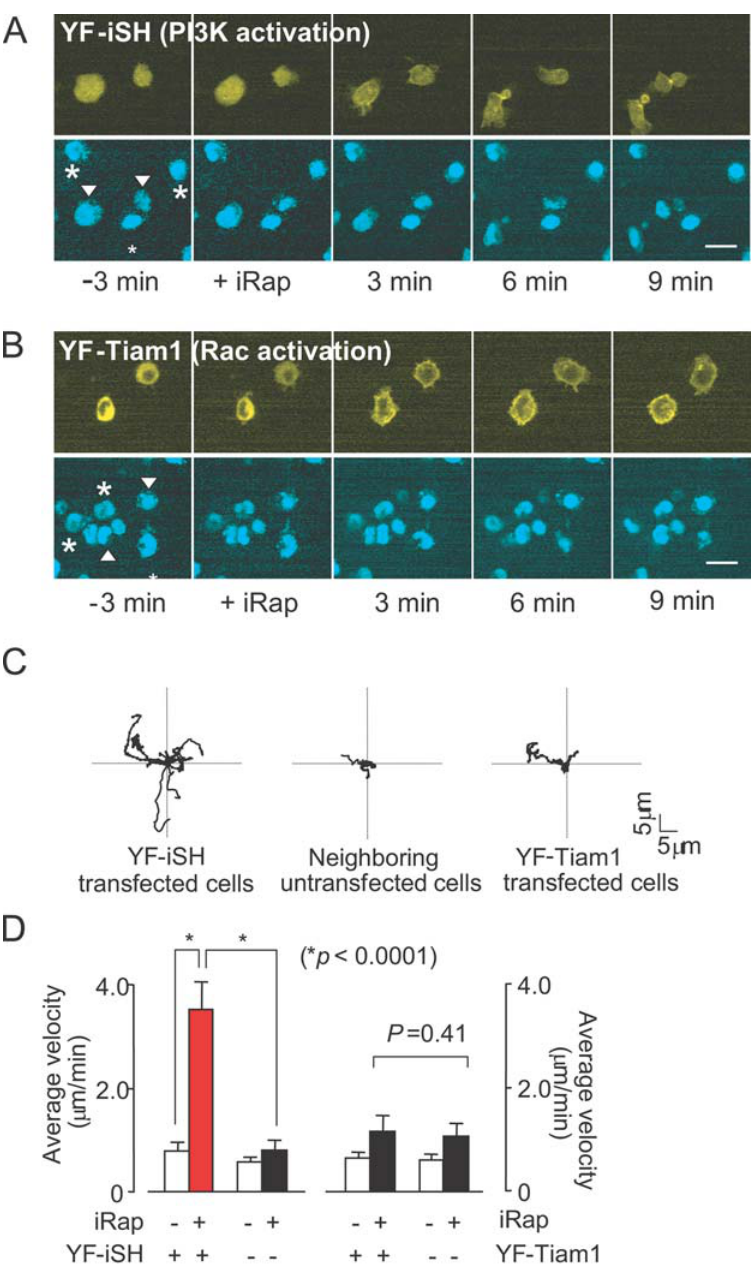
Figure 2. Synthetic activation of endogenous PI3K, but not of endogenous Rac, induces neutrophil polarization and migration. Dual color fluorescent images of differentiated HL-60 cells are shown every 3min before and after iRap addition. (A) Neutrophils polarize and begin to migrate in response to synthetic activation of PI3K. (B) Neutrophils induce non-polar pseudopods in response to synthetic activation of endogenous Rac and do not migrate. Synthetic activation of Rac was based on the forced translocation of catalytic Rac GEF activity (from the exchange factor TIAM). FKBP-YFP-TIAM construct (YF-Tiam1) was expressed instead of the YF-iSH construct. In both image series, the top rows shows the YFP-tagged activation peptides (YF-iSH for PI3K or YF-Tiam1 for Rac), and the bottom images show DyeCycle-labeled nuclei. Arrowheads in images of the nuclei point to the transfected cells, whereas asterisks mark untransfected cells. (C) Migration paths of 10 representative cells for each condition. The initial location was normalized to the origin. Cells after synthetic activation PI3K (left), untransfected control cells in the same field of view (middle), and cells after synthetic activation of Rac (right). (D) Average velocity of cells before and after PI3K activation or Rac activation. Graph shows the velocity at 1.5 min before and 6 min after iRap addition. Error bars, S.E.M. (n=20 from four independent experiments). Scale bars, 10 m